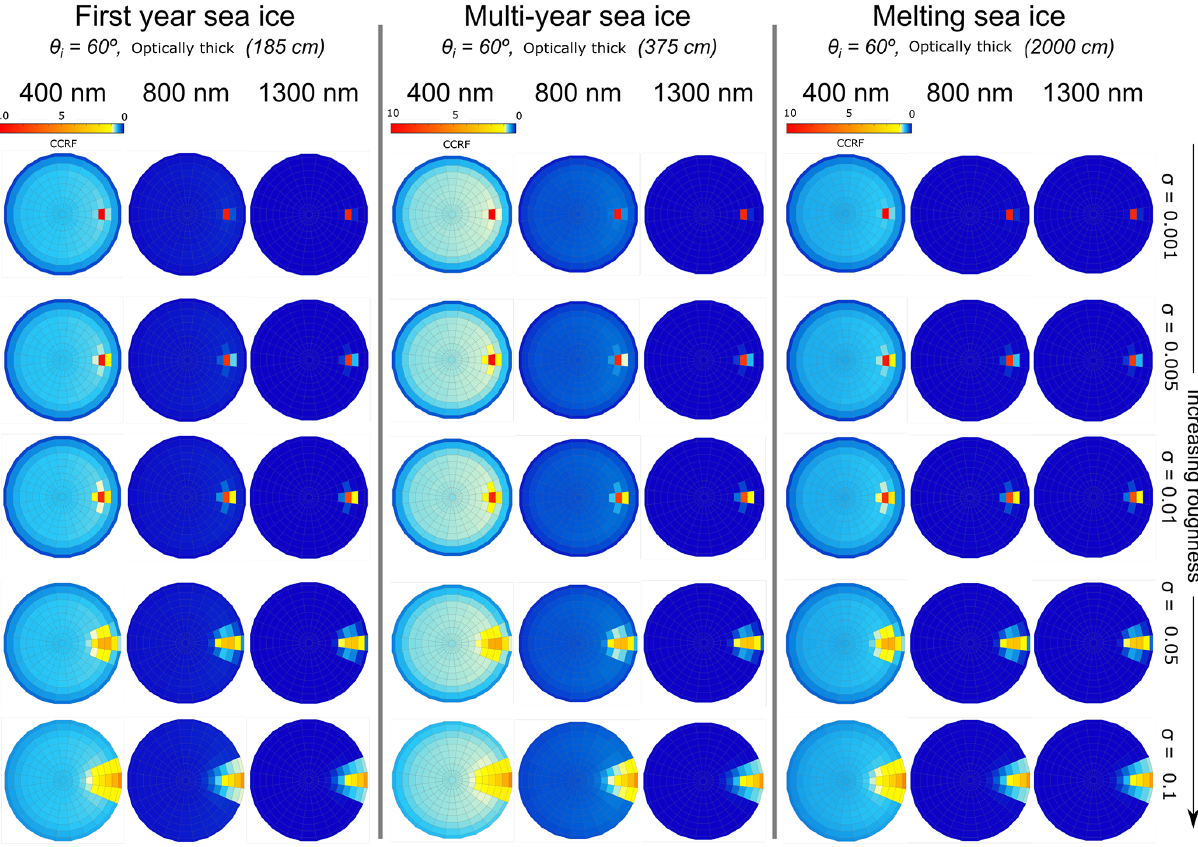
Figure 8. CCRF of optically thick first-year sea ice, multi-year sea ice and melting sea ice with an increasing surface roughness for λ = 400, λ = 800 and λ = 1300. The incident angle is θ i = 60 ◦